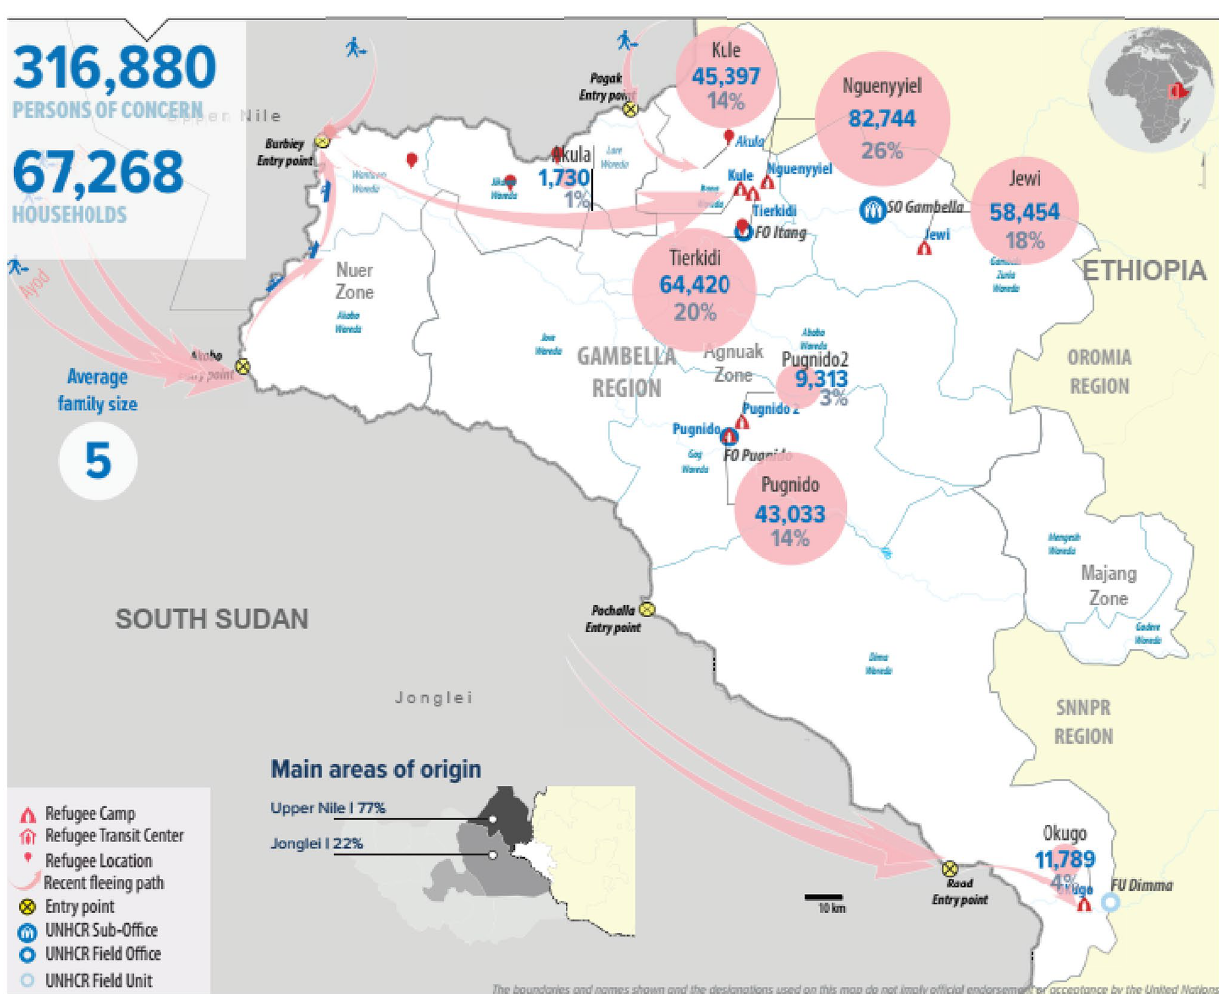
Fig. 2 Refugee population in Gambella region, Ethiopia